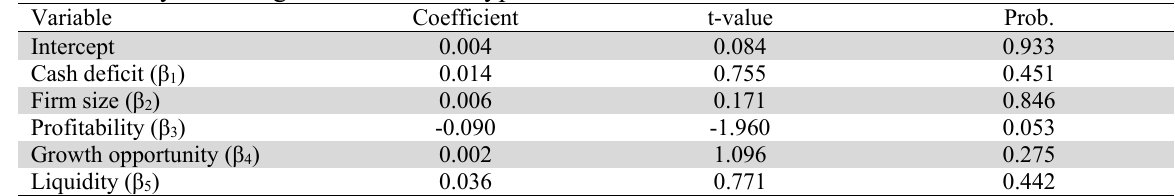
The summary of testing the second